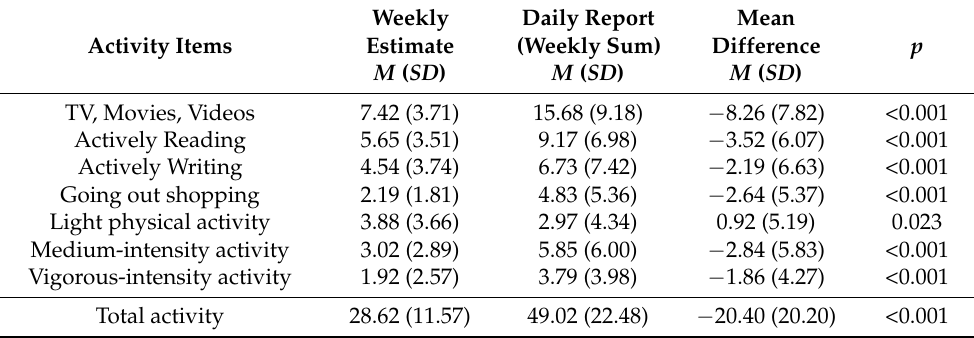
Table 2. TRAILLs Study: Estimated Weekly and Reported Daily Activity (summed over 1 week) for 12 Activity Items